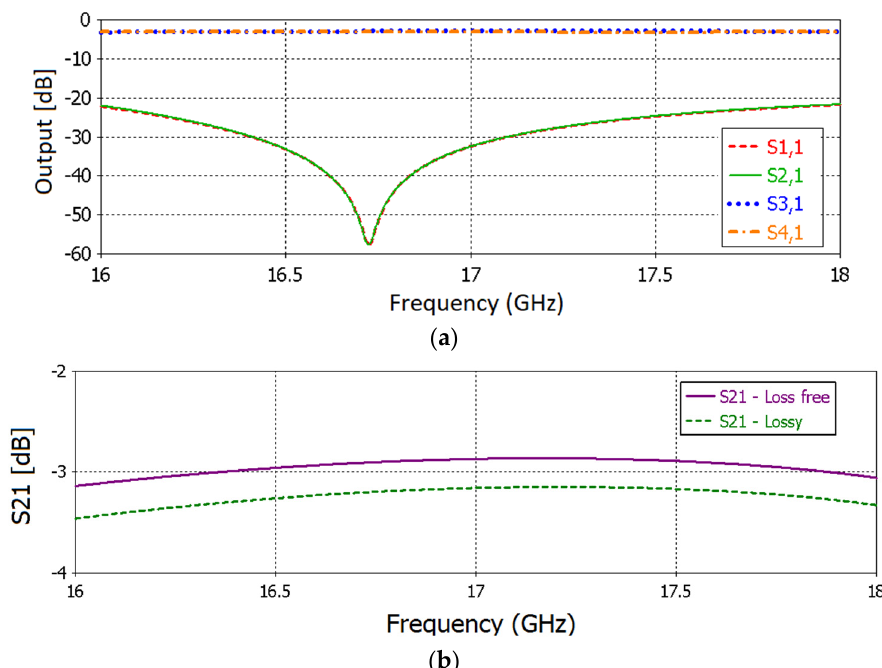
Figure 2. Scattering parameters of the 3 dB coupler, ( a ) ideal, ( b ) S 21 = S 31 with dielectric and metal losses included compared to lossless analysis.